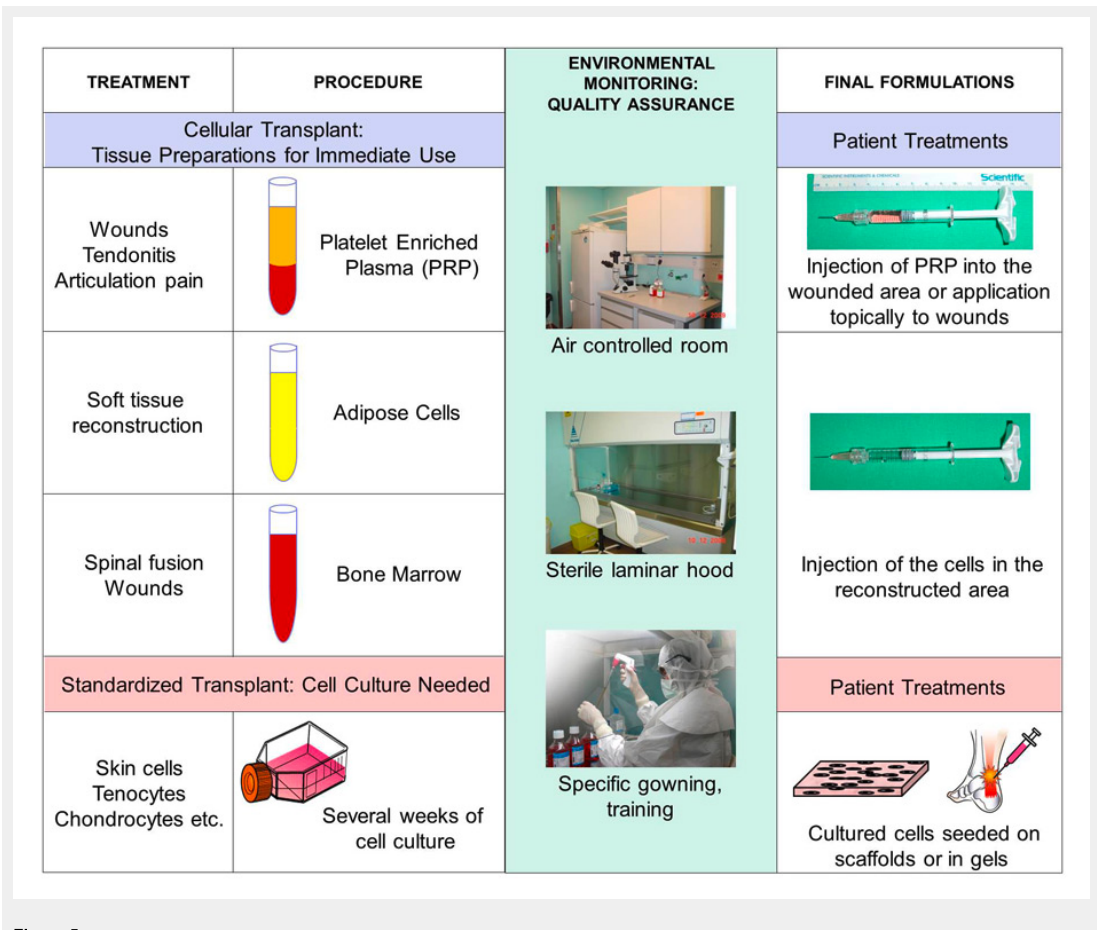
Regulatory requirements for cellular therapy products. Regulatory requirements have become more extensive for cellular therapies and tend towards conservative drug development in their production, pre-clinical testing and clinical trials. Blood products also have to be produced under cGMP and only in institutions with a license for manipulation. Organs, cells and tissues (PRP, adipose, bone marrow, skin, cartilage, tendon etc.) need to be processed with environmental monitoring and full quality assurance with cGMP processing through to the final formulation and delivery to the